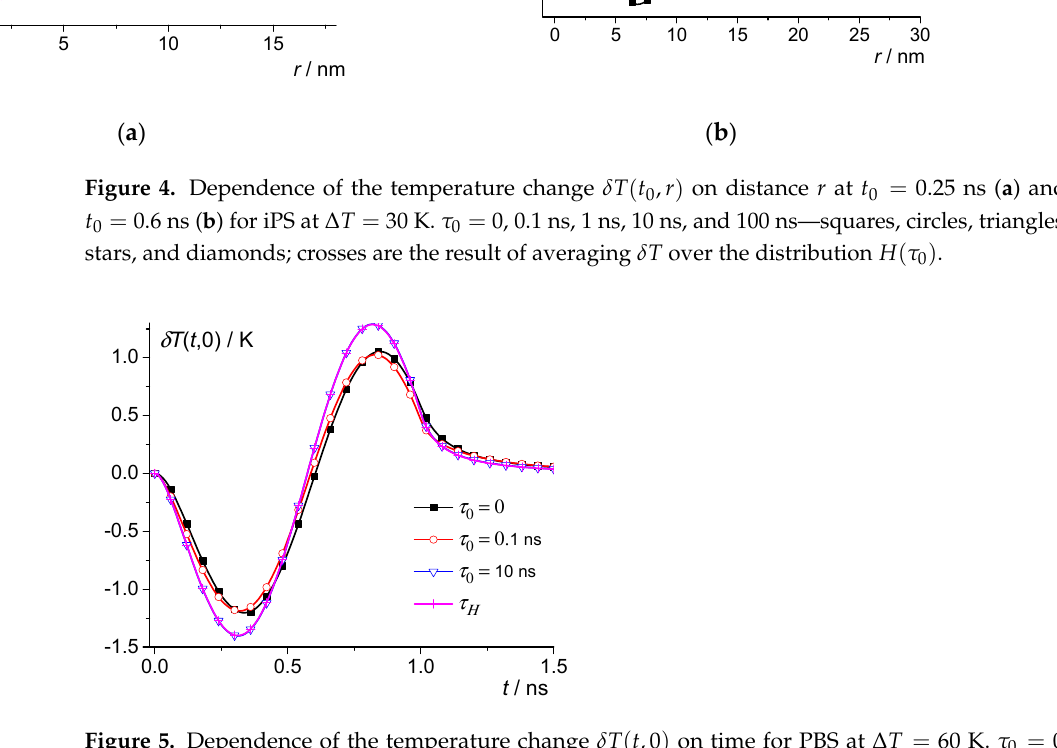
Figure 5. Dependence of the temperature change δ T ( t ,0 ) on time for PBS at ∆ T = 60 K. τ 0 = 0, 0.1 ns, and 10 ns—squares, circles, and triangles; crosses are the result of averaging δ T over the distribution H ( τ 0 )